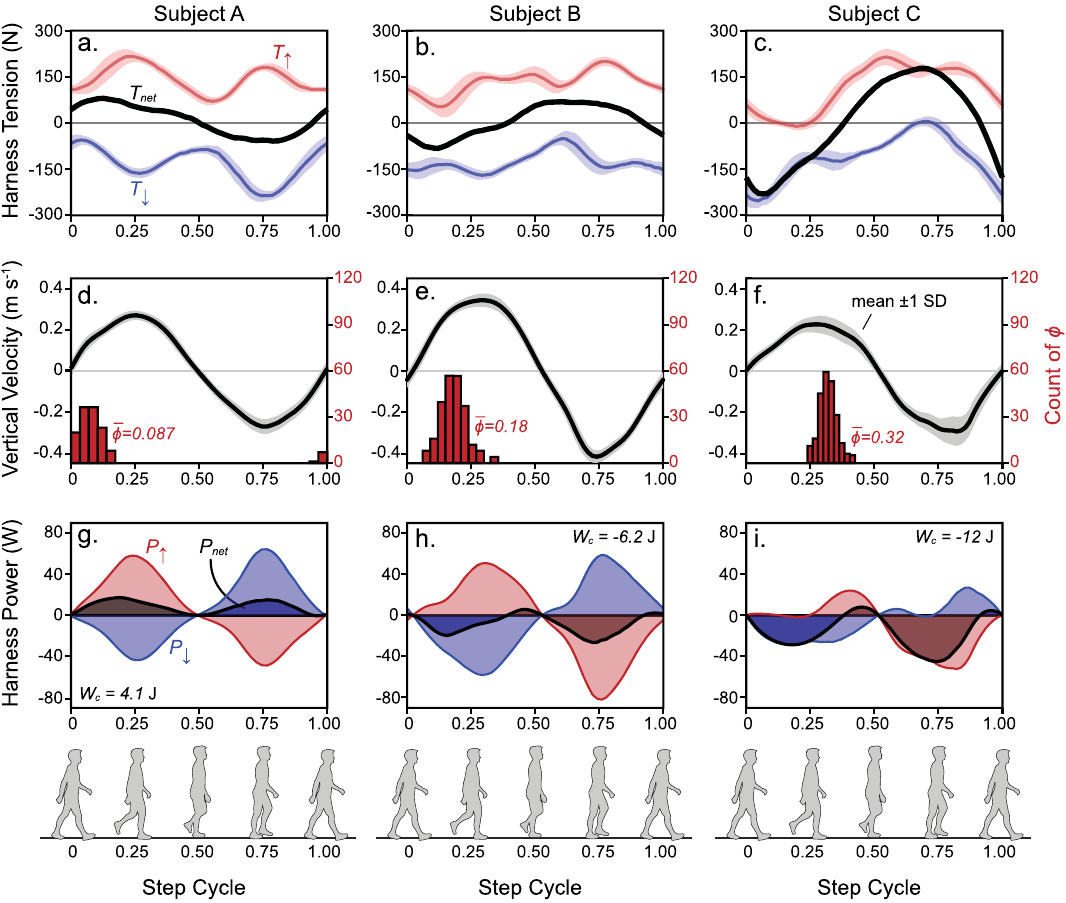
Figure 7. Subjects prefer a range of phase alignments, resulting in variable net power. Data from three subjects were chosen to demonstrate varying entrainment strategies. Mean data ( ± 1 intrasubject standard deviation, SD, in shading) for Subject A ( (cid:31) f m = 6% , A m = 30% BW , 297 steps averaged) are shown in ( a ), ( d ) and ( g ), where motor phase alignment occurs at φ = 0.087 of the step cycle. This strategy aligns peak tension forces with the center-of-mass (CoM) vertical velocity and thus, results in net positive work ( W c = 4.1 J ). Mean data ( ± 1 SD) for Subject B ( (cid:31) f m = − 6% , A m = 30% BW , 475 steps averaged) are shown in ( b ), ( e ) and ( h ) where motor phase alignment occurs at φ = 0.18 of the step cycle. Since peaks in tension due to motor forces occur slightly later, positive power is relatively low and net negative work occurs ( W c = − 6.2 J ). Mean data ( ± 1 SD) for Subject C ( (cid:31) f m = − 6% , A m = 30% BW , 444 steps averaged) are in ( c ), ( f ) and ( i ) where φ = 0.32 of the step cycle, and mechanical power from the harness tension is dominated by resistive inertial forces, thus leading to substantial net negative work on the CoM ( W c = − 12 J ). Work done on subjects by the harness forces are represented with shading underneath the power curves. Data points for subjects A, B and C are labelled in Fig. for minimizing work while walking with an oscillating impulse applied to the CoM 26 . This strategy aligns upward oscillator forces with the step-to-step transition (phase = 0 ◦ ). The upward oscillator force does some work that the